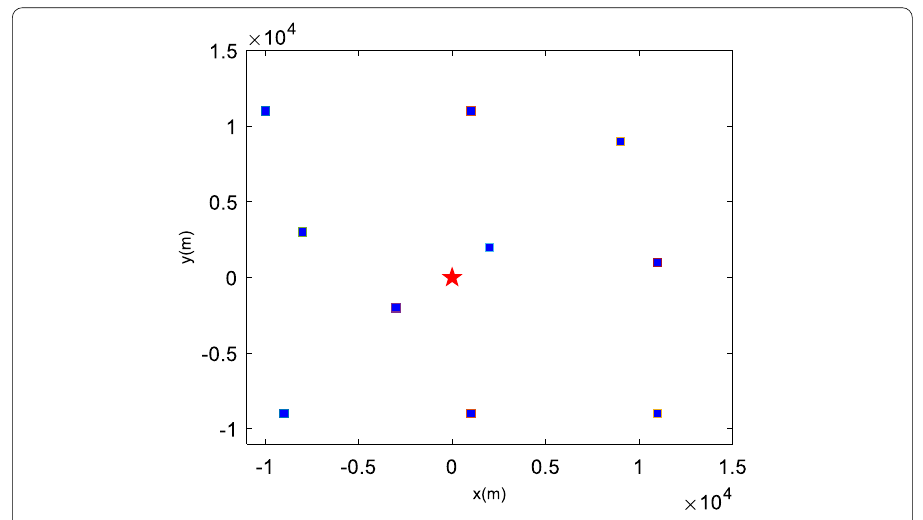
Fig. 3 The locations of receivers (blue squares) and the transmitter (red